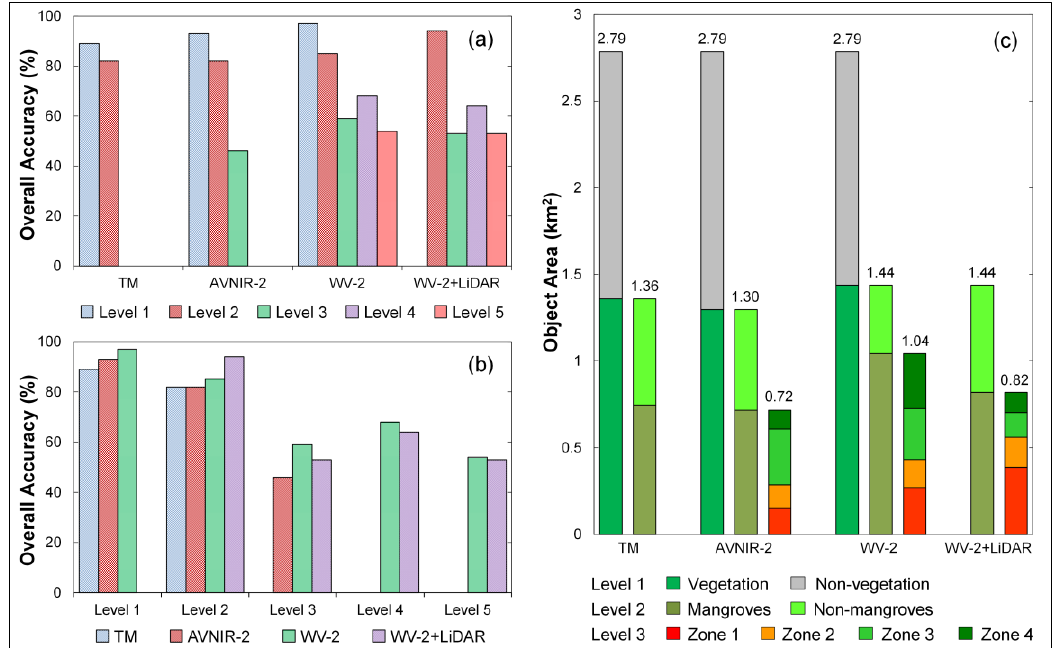
Figure 10. Comparison of the overall accuracy result of ( a ) different images and ( b ) different levels, and ( c ) area of the produced maps for level 1, 2, and 3 in Whyte Island, Moreton